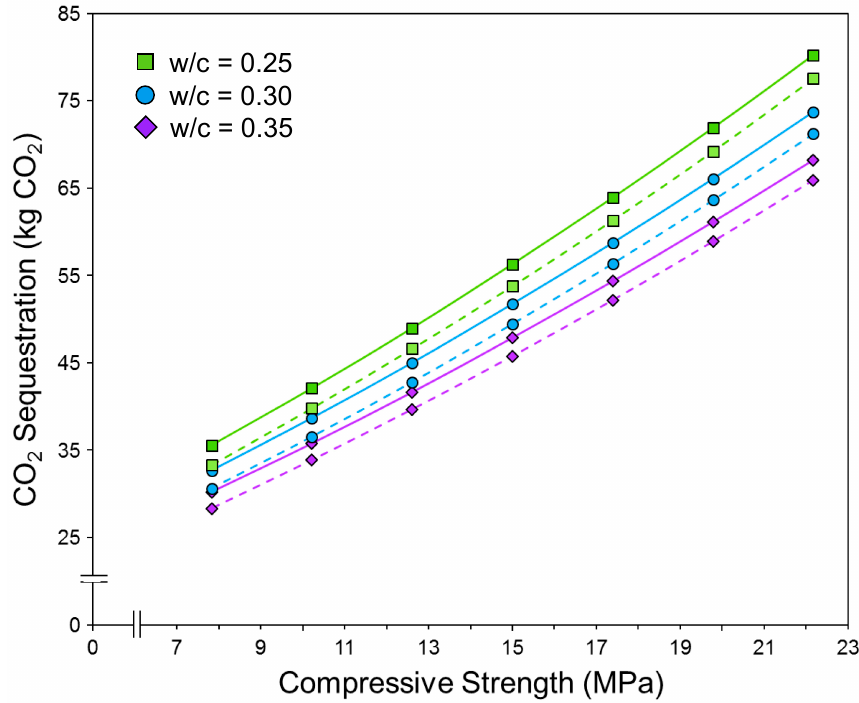
Figure 4. Effect of compressive strength on the CO 2 sequestration potential of 1 m 3 of pervious concrete with varying water-to-cement (w/c) ratios and both 9.35 mm (—) and 6.35 mm (- - -) aggregate.